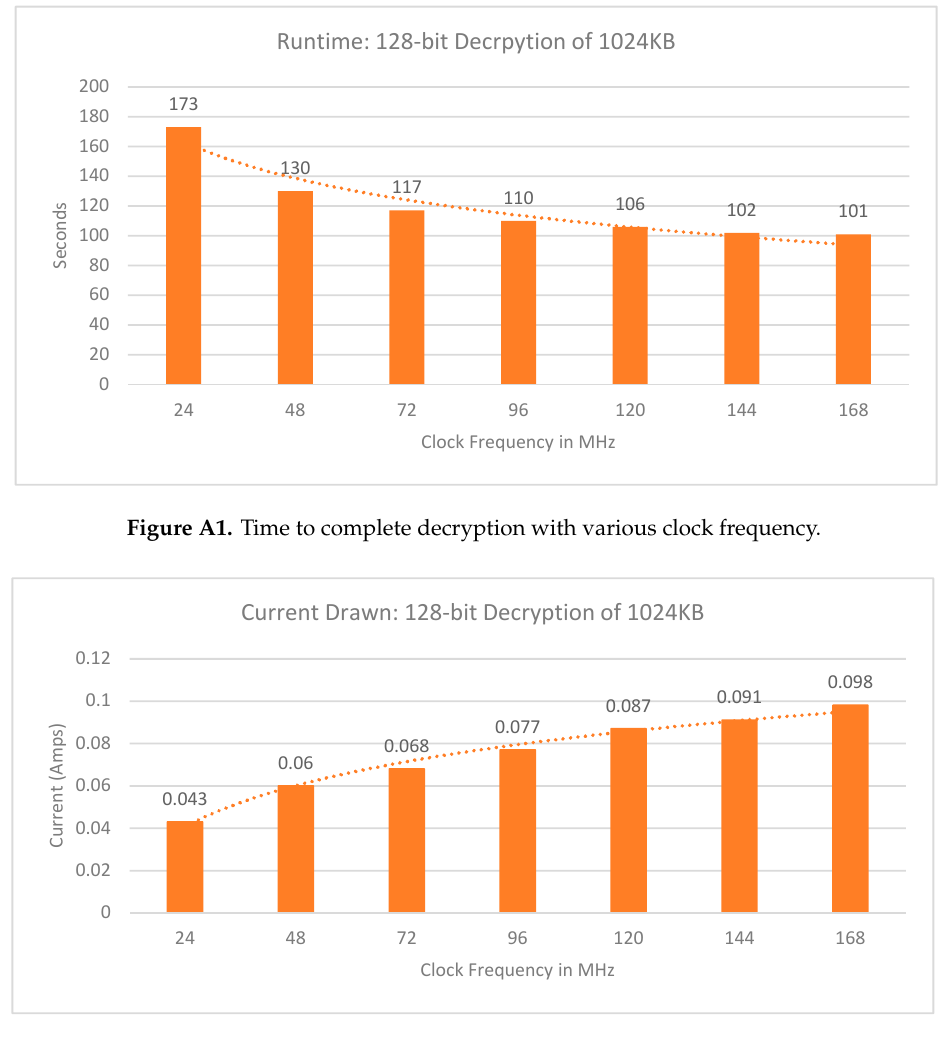
Figure A2. Current drawn to decrypt 1024KB text file with various clock frequency.